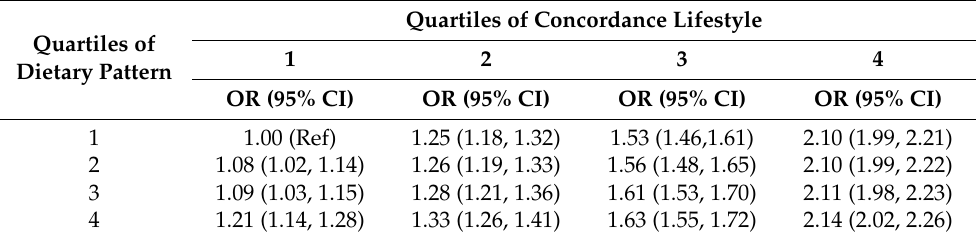
Table 5. Adjusted interaction models between dietary pattern and concordance lifestyle across the quartiles for the risk of abnormal liver function ( n = 62,645) a . Quartiles